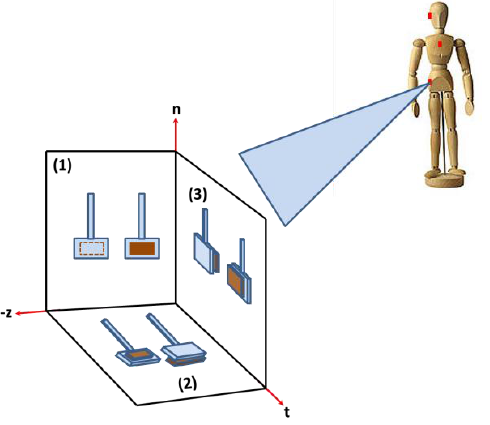
Figure 10. A schematic of the proposed sensor for any